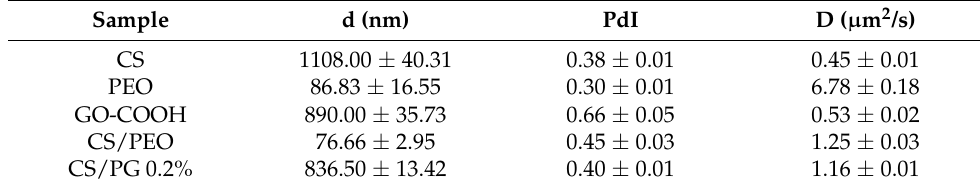
Table 2. The hydrodynamic characteristics of raw materials and CS/PEO and CS/PG 0.2% dispersions.